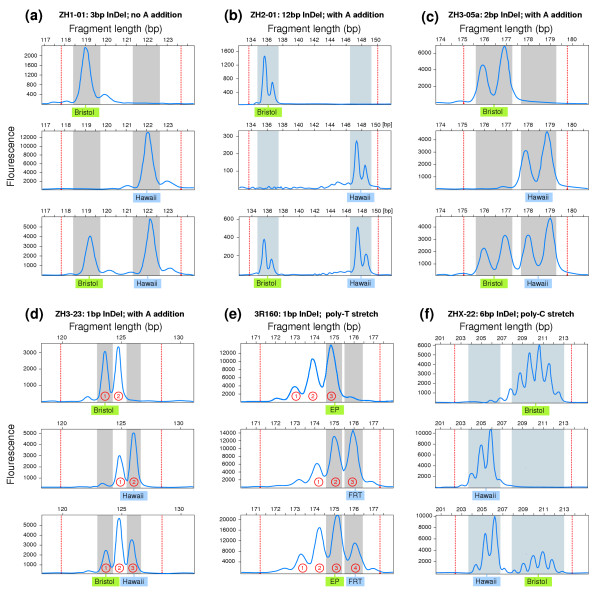
FLP detection of InDels of various sizes in homozygotes and heterozygotes. In each panel the top two graphs show the homozygotes and the bottom graph the heterozygote. Gray shaded areas mark the defined expected allele lengths and red lines indicate the borders of a predefined window of expected allele lengths. (a-c) Detection of InDels in C. elegans that show increasing levels of adenosine (A) addition. (a) 3-bp InDel ZH1-01 with no A addition; (b) 12-bp InDel ZH2-01 with A addition; (c) 2-bp InDel ZH3-05a with A addition. (d) 1-bp InDel ZH3-23 in C. elegans with A addition. An unambiguous allele-call can be made, irrespectively of the level of A addition: both homozygous samples consist of two peaks at different positions, whereas the heterozygous animal exhibits three peaks. (e) The 1-bp InDel 3R160 in Drosophila runs over a 12-13 nucleotide poly(T) stretch and exhibits stutter bands. Even in this case, a clear allele-call can be made (three peaks in homozygous and four peaks in heterozygous animals). (f) The 6-bp InDel ZHX-22 in C. elegans occurs in a poly(C) stretch and the FLP graph displays stutter bands. As expected, the longer fragment exhibits a higher degree of stuttering.